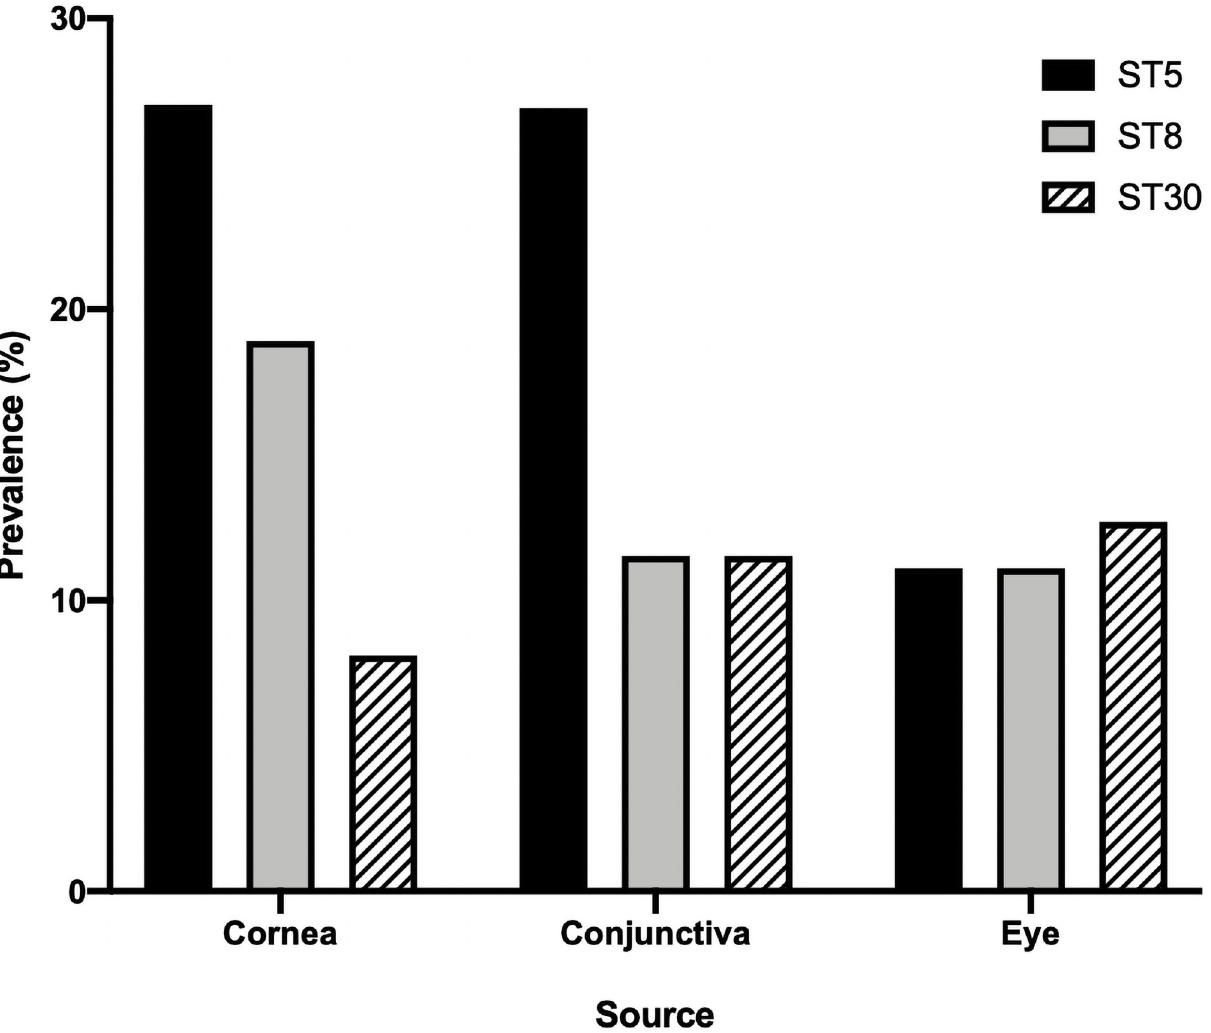
Fig 2. Prevalence of the three most abundant multilocus sequence types (MLST) among ocular S . aureus isolates based on specific anatomic